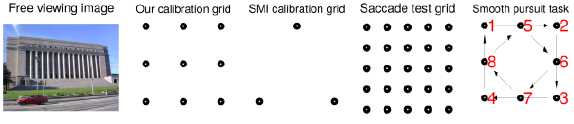
Figure 12. From left to right: The image presented dur- ing the free viewing task and schematic grids of the cali- bration, saccade, and smooth pursuit tasks (not to scale) with the starting and turning points (with running num- ber) and movement directions of the dot in the task (i.e., the sequences are 1-2-3-4-1, jump, 5-6-7-8-5). Note that only one grid point was visible at a